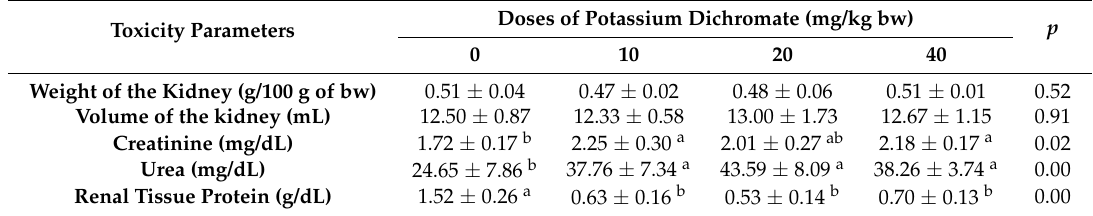
Table 2. Effects of potassium dichromate on kidney weight and volume and biochemical markers of nephrotoxicity in rabbit does.